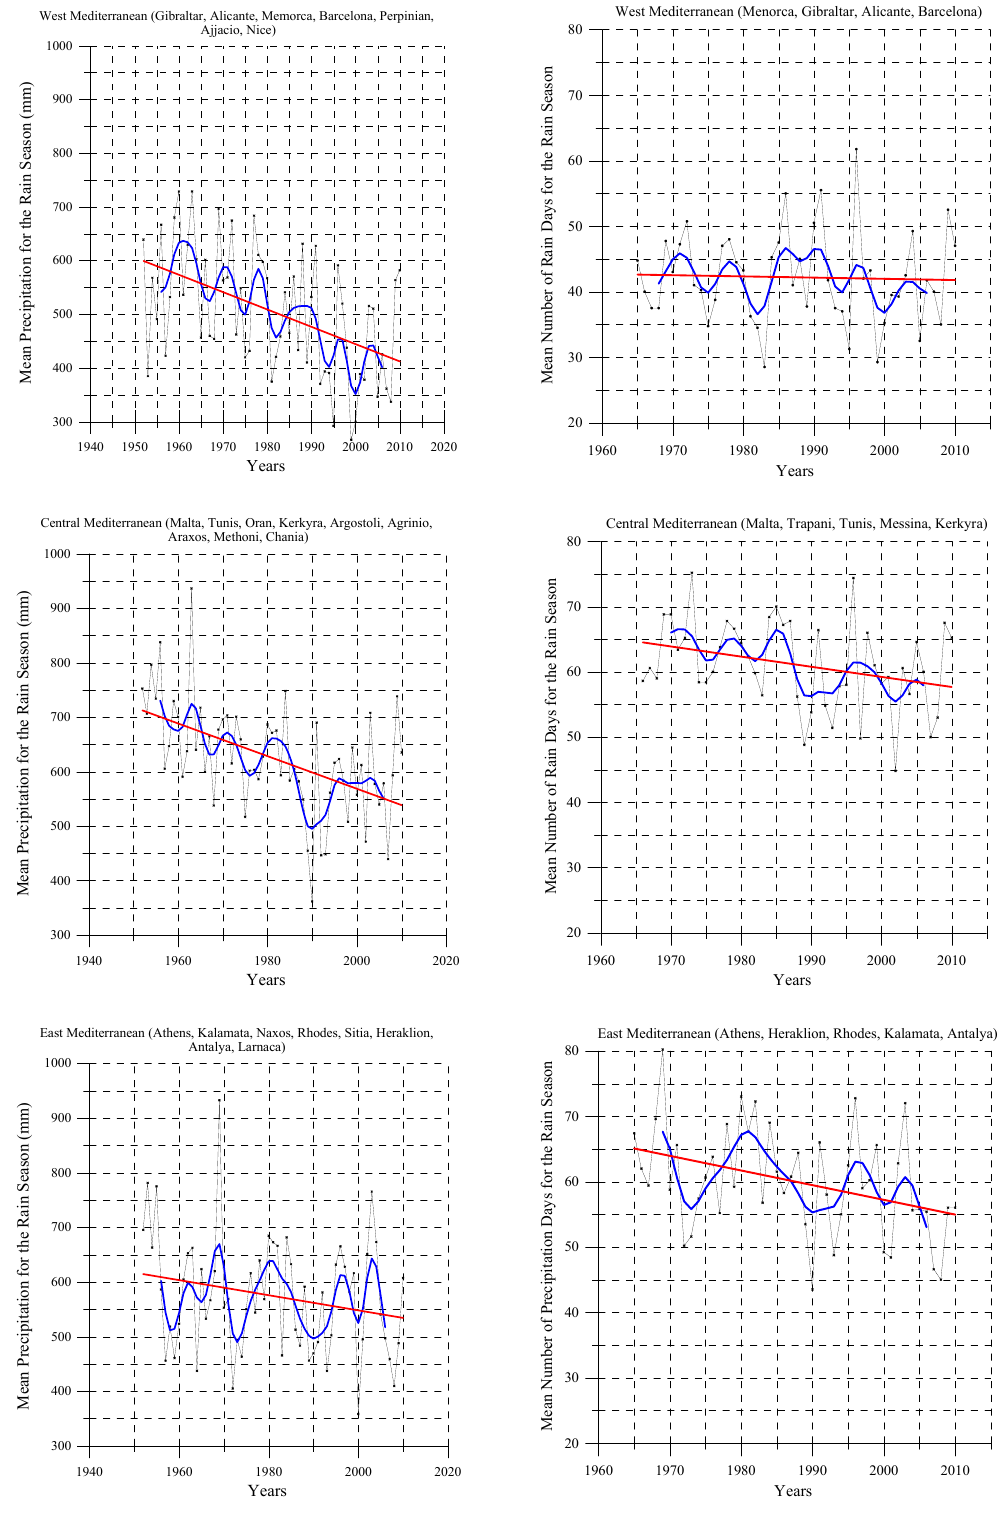
Fig. 6. Composite precipitation (left graphs) and number of rain days (right graphs) for the rain season (October–March) from representative stations of the west (upper), central (middle) and east (lower) Mediterranean region, along with 9-yr Gaussian filter (blue line) and linear trend (red line).